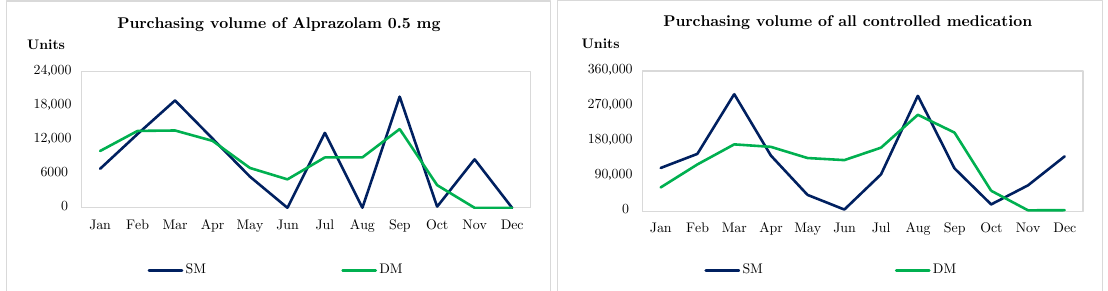
Figure 3. Purchasing volume, during 2018, of Alprazolam 0.5 mg and of all controlled medication (in